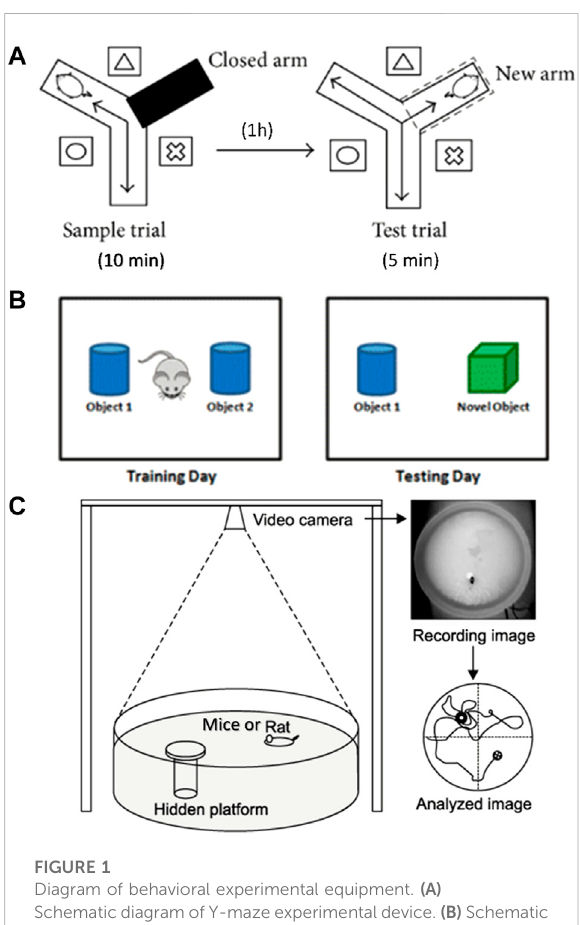
FIGURE 1 Diagram of behavioral experimental equipment. (A) Schematic diagram of Y-maze experimental device. (B) Schematic diagram of NOR experiment. (C) Schematic diagram of Morris water maze